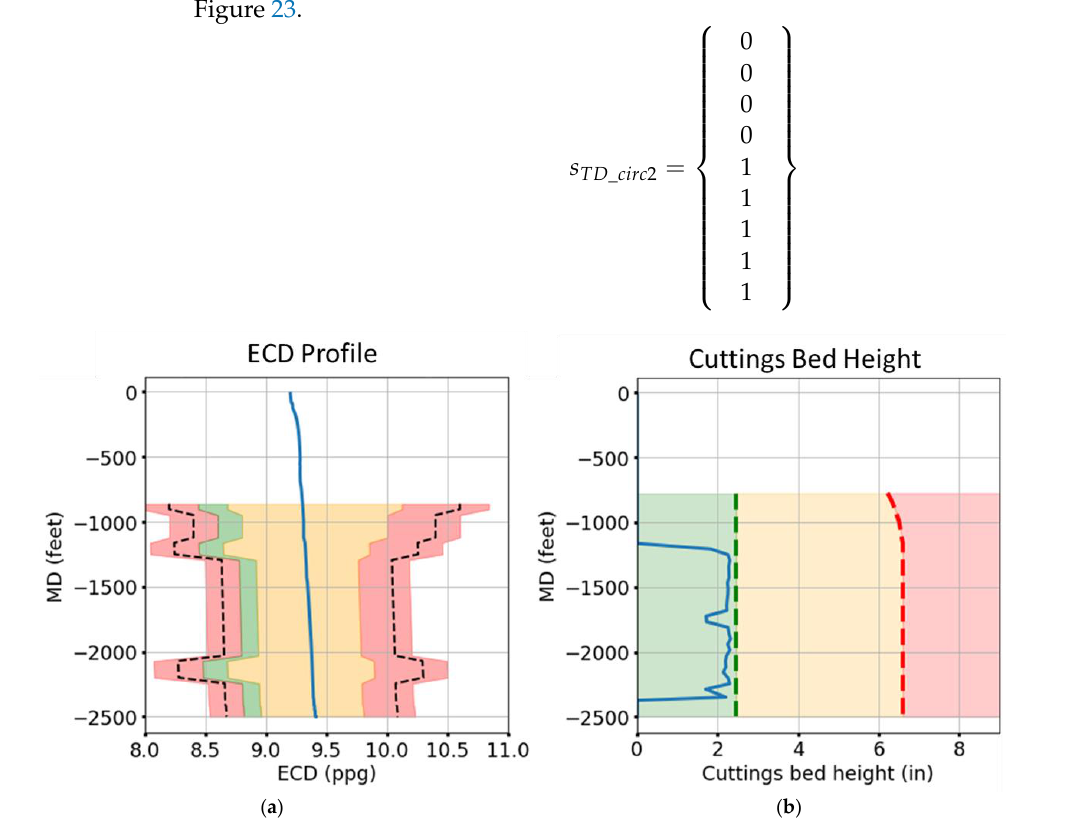
Figure 23. ( a ) ECD profile ( b ) Cuttings bed height. The normalized Euclidean distance does decrease with time, but it only reaches the 0.2 line on the seventh action (Figure 24b). An interesting observation in Figure 24a is that the cuttings bed is not entirely removed but is reduced to the goal state (green-shaded zone) values. The ECD is also in the safe-but-suboptimal region, but it is much higher than for the first case due to a higher suggested mud density.